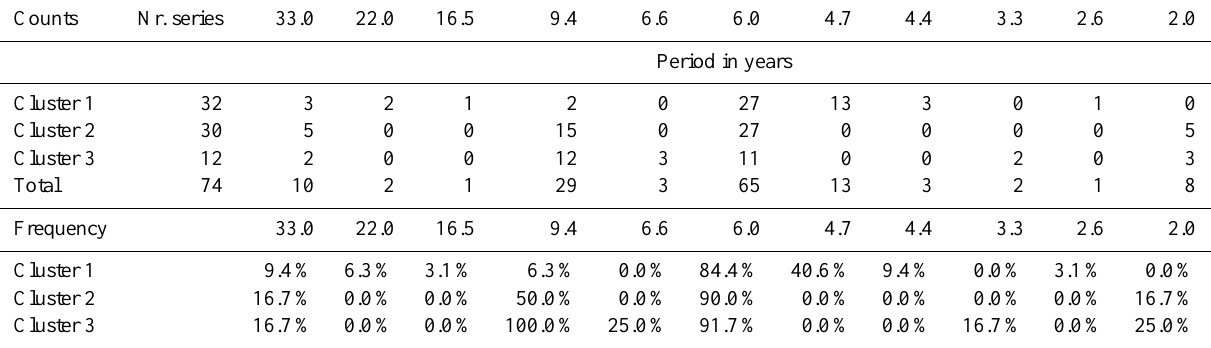
Table 2. The counts per cycle and per cluster and its frequency (%) relative to the number of series included in each cluster (just the significant cycles of the